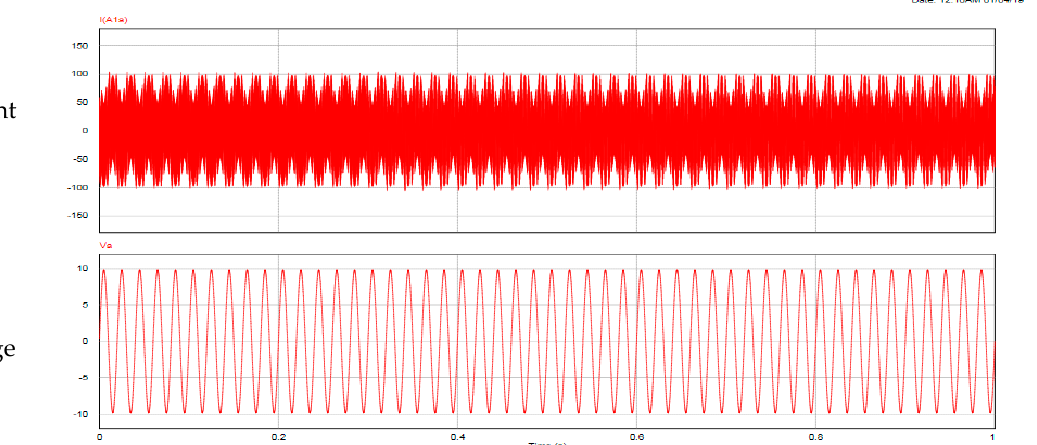
World Electric Vehicle Journal 2019 , 10 , x FOR PEER REVIEW Figure 20. Inverter output voltage and current. Figure 20. Inverter output voltage and current.